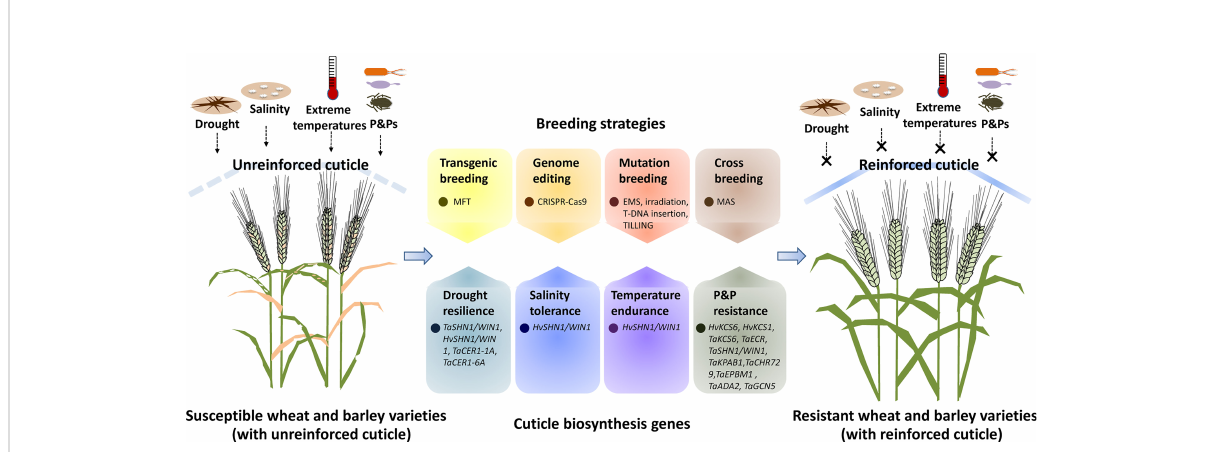
FIGURE 1 A simpli fi ed model for manipulating cuticle biosynthesis to improve abiotic and biotic stress tolerance in wheat and barley. Cuticle biosynthesis genes in wheat and barley get involved in the regulation of plant response to abiotic and biotic stresses such as drought, salinity, extreme temperatures, and attacks of pathogens and pests (P&Ps). Genetic manipulation of these cuticle biosynthesis genes by transgenic breeding, genome editing, mutagenesis breeding and cross breeding could reinforce the cuticle, resulting in improved abiotic and biotic stress resistance in wheat and